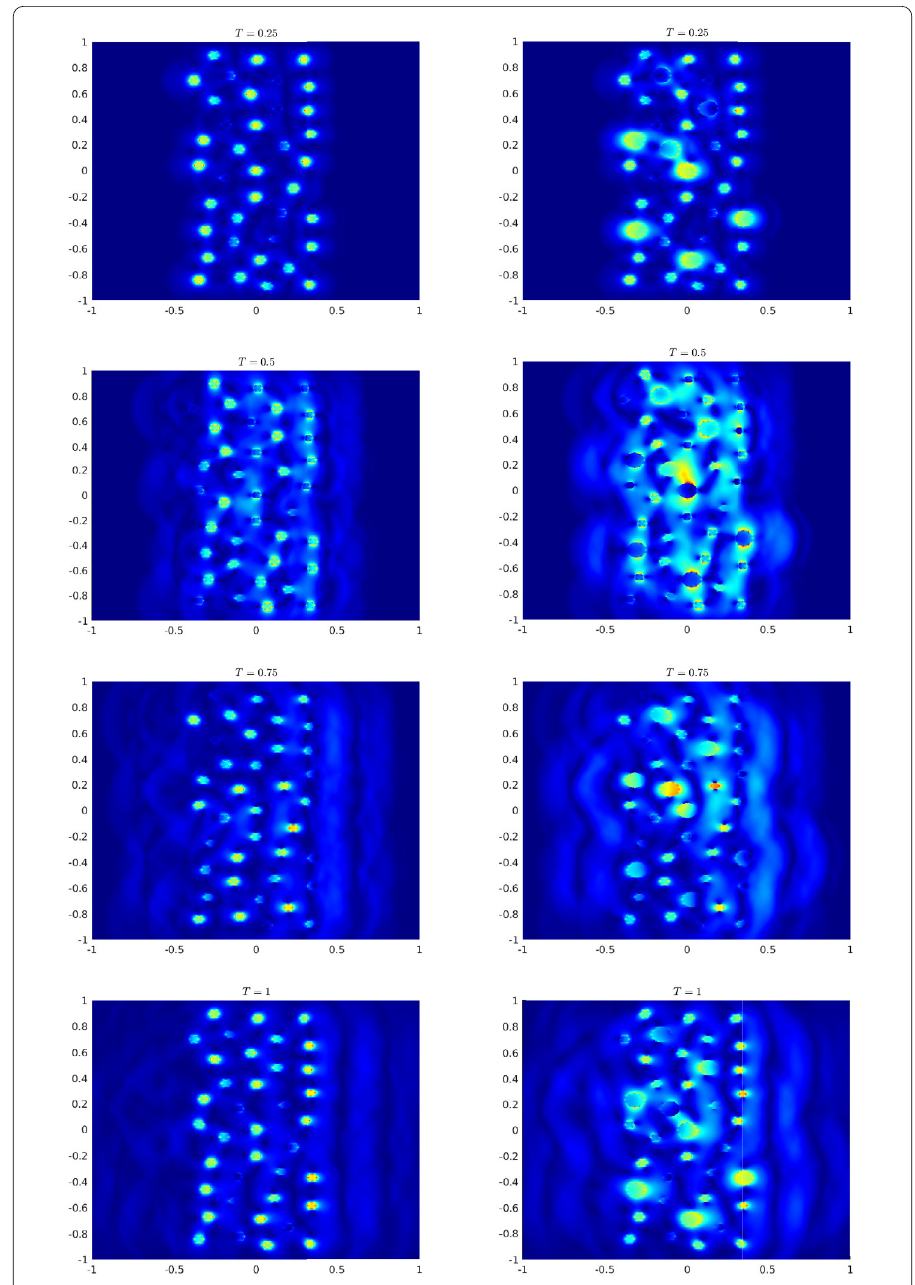
Figure 4 Time evolution of scattered electric field intensity I s . Left: healthy cornea; Right: cornea with some fibres whose diameter is